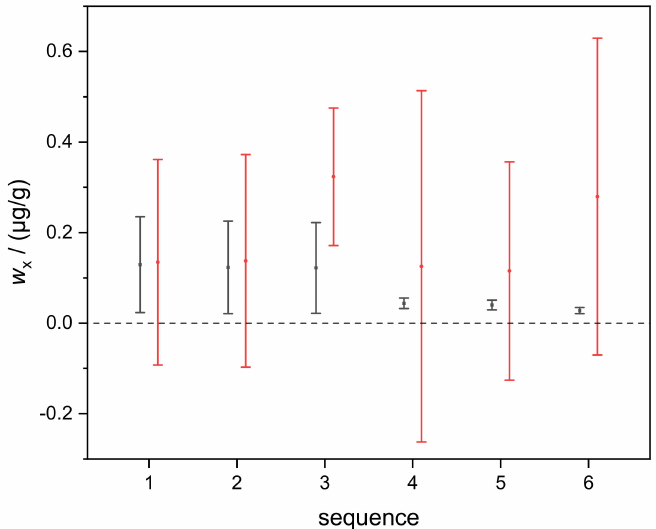
Figure 9. Black circles (error bars): mass fractions w x (Si) and the associated uncertainties ( k = 1) of six runs determined using the approach of this work. Red circles (error bars): results of the same input data (blends b 2 , b 3 , b 4 only) using the approach of